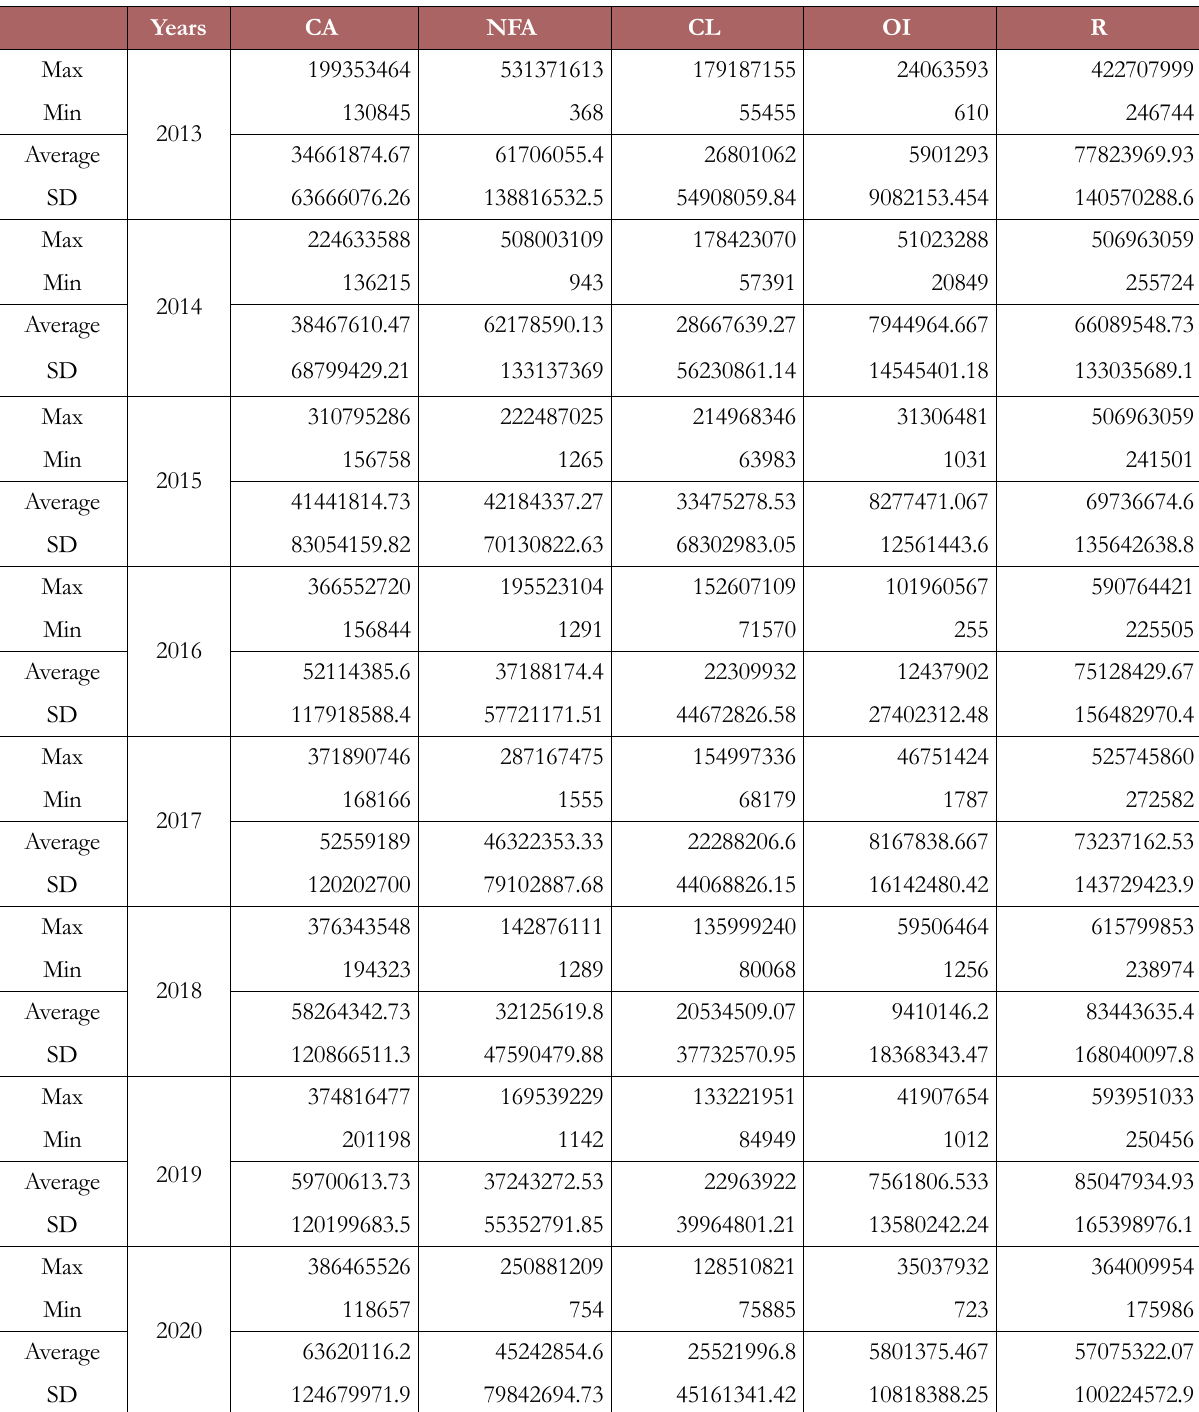
Table 3. Descriptive statistics of inputs and outputs from 2010 to